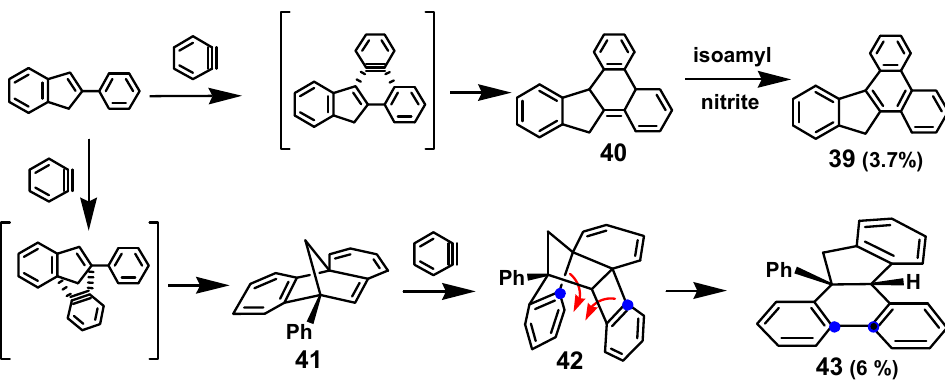
Scheme 17. Cycloaddition reactions of benzyne to 2-phenylindene.